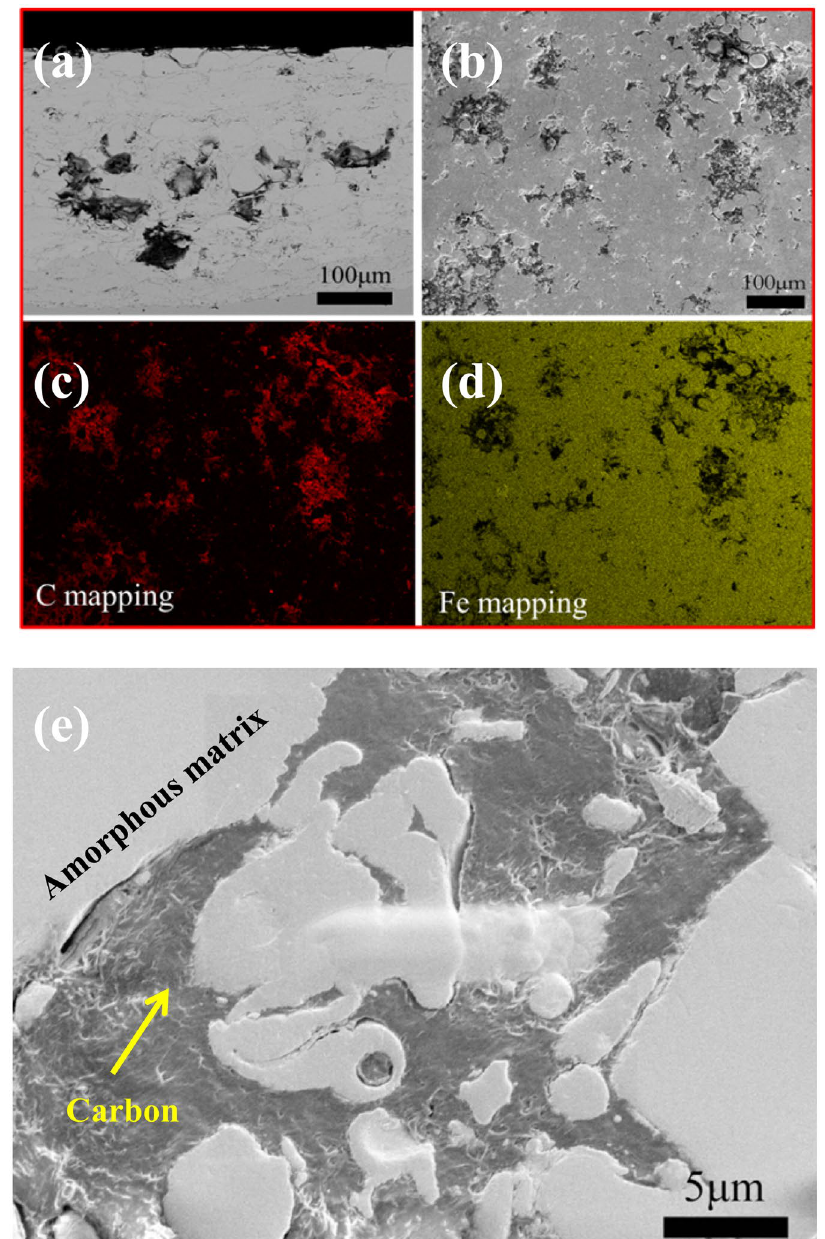
Figure 2. ( a ) Cross-section morphology of the composite coating. ( b ) Surface morphology of the composite coating with the corresponding EDX mapping of C and Fe ( c,d ), showing the uniform distribution of carbon particles in the coating. ( e ) High-magnification image showing the good combination of the amorphous matrix and amorphous carbon